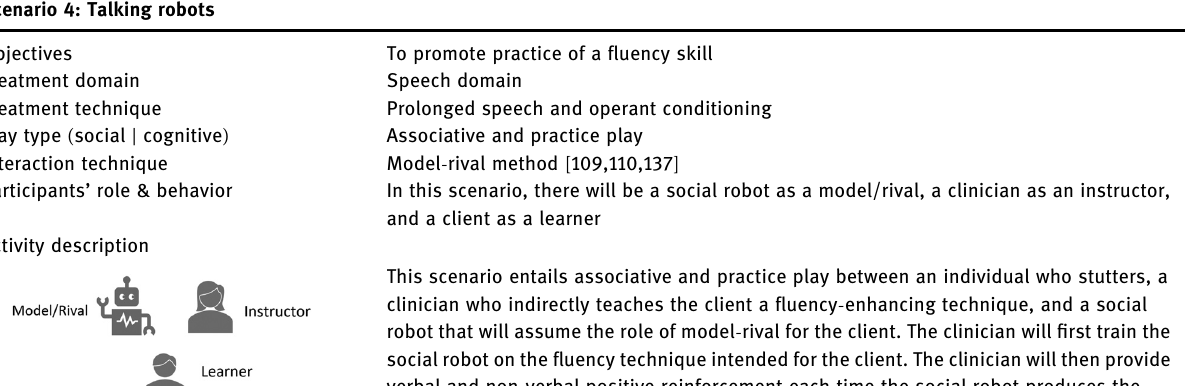
Table 4: Description of scenario